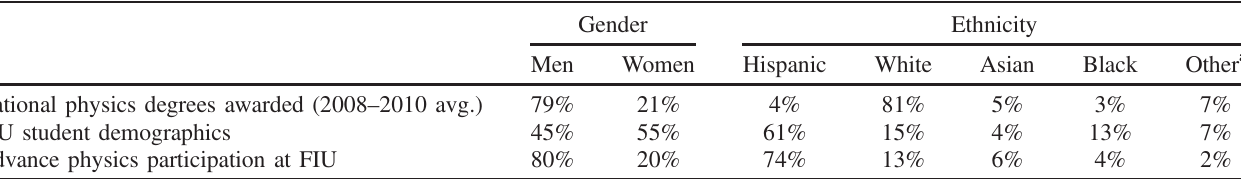
TABLE I. Study demographics and national and FIU comparison